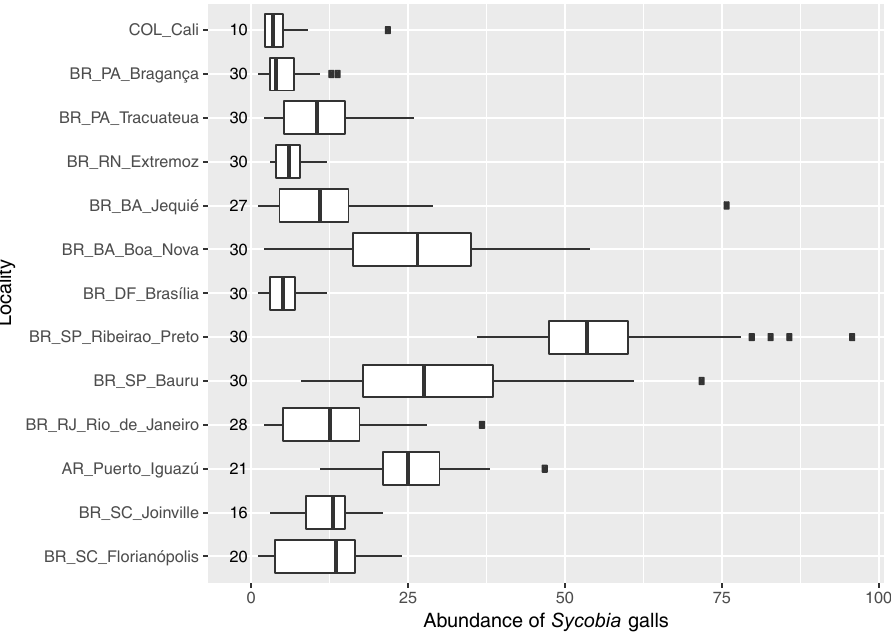
Figure 3. Average abundance of Sycobia hodites Farache & Rasplus, sp. n. galls in Ficus benjamina. The number of galls was calculated when Sycobia was present in the figs. Localities sorted by latitude. Coun- tries: AR = Argentina, BR = Brazil, COL = Colombia; Brazilian States: BA = Bahia, DF = Distrito Federal, PA = Pará, RJ = Rio de Janeiro, RN = Rio Grande do Norte, SC = Santa Catarina, SP = São Paulo. Num- bers on the left side of the plot indicate sample